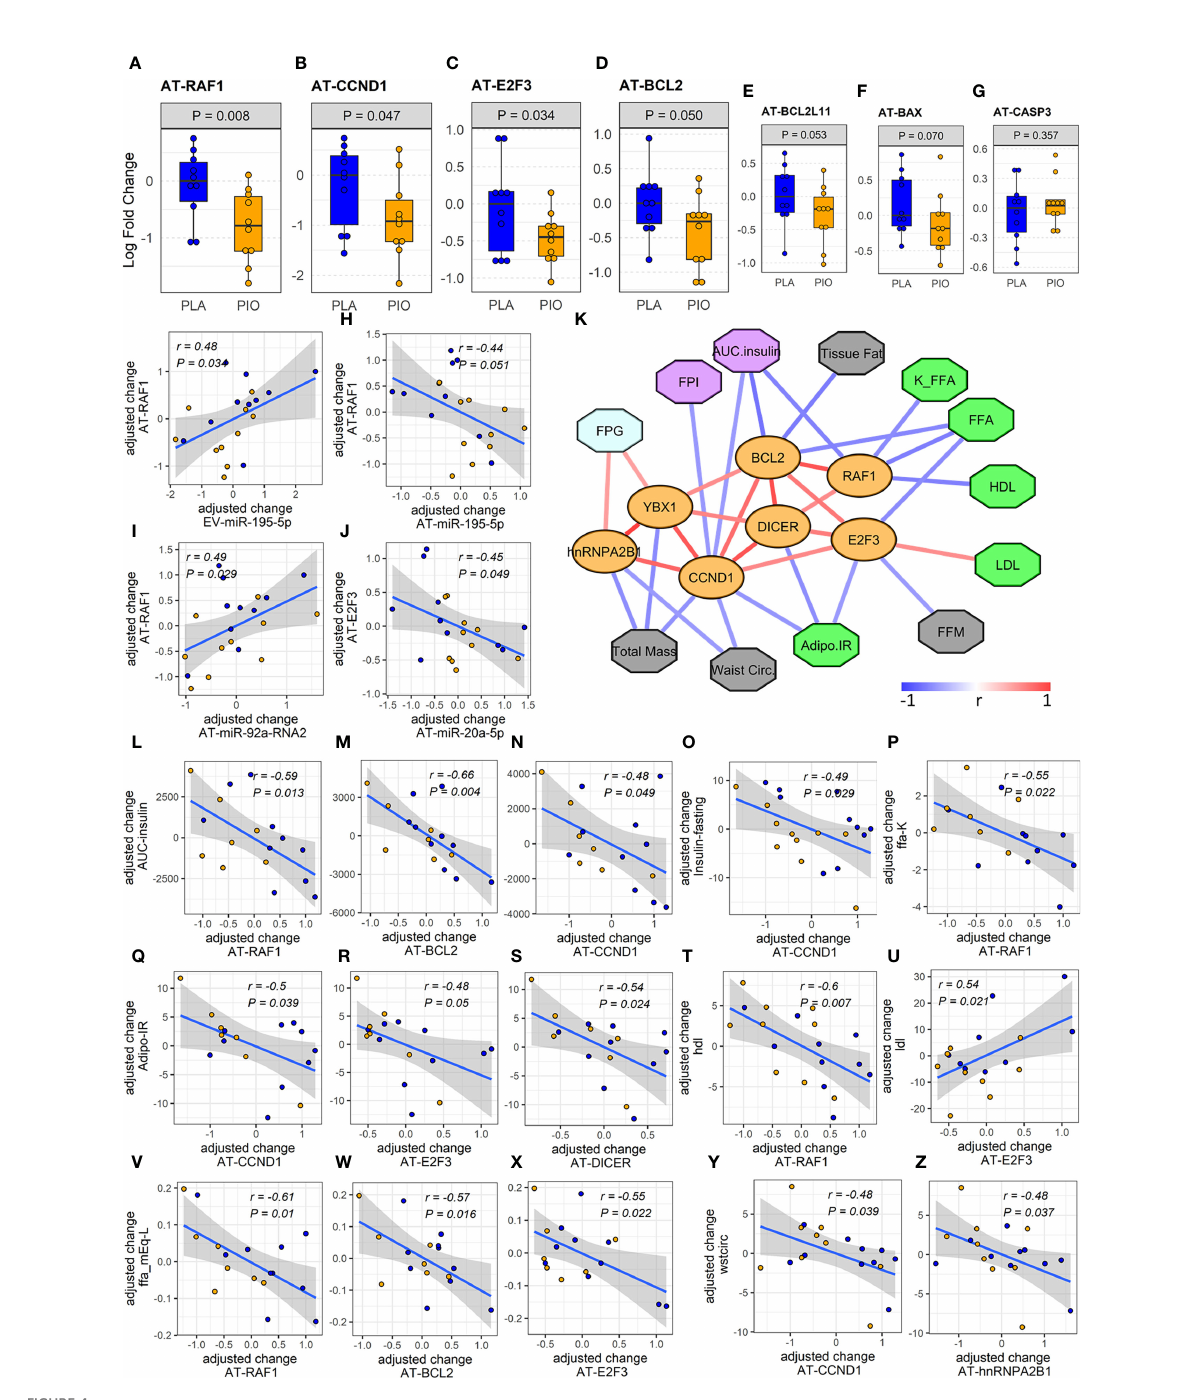
FIGURE 4 Expression and associations among AT genes found to be overtargeted by the DE EV-miRNAs. (A-E) Pro fi les of differentially expressed overtargeted AT genes. (F, G) Pro fi les of pro-apoptotic BAX and CASP3 genes in AT. (G-J) Signi fi cant correlations between the change in DE overtargeted AT genes and the change in circulating DE EV-miRNA and AT-miRNAs. (K) Correlation network of signi fi cant ( P <0.05, FDR<0.1) associations among AT genes involved in miRNA biogenesis/exosomal sorting, experimentally validated AT genes overtargeted by the DE EV- miRNAs (orange ovals), and clinical measures relevant to lipid metabolism (green octagons), body composition (grey octagons), glycemic control (cyan octagons), and b cell function (purple octagons). (L-Z) Correlation plots between the change in DE AT genes and the change in relevant clinical measures. Waist circ or wstcirc, waist circumference; FPG, fasting plasma glucose; FPI, fasting plasma insulin; AUC.insulin, insulin area under the curve; FFM, free fat mass; FFA, free fatty acids; K_FFA or ffa.K, rate of free fatty acid disappearance; LDL, low density lipoprotein; HDL, high density lipoprotein; Adipo.IR, insulin resistance in adipose